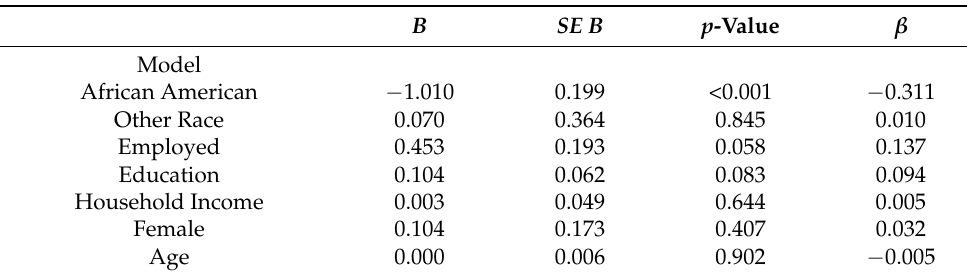
Table 4. Ordinary Least Squares Regression Coefficients to Predict Prevalence of Breastfeeding with Multiple Imputation ( n = 419). B SE B p -Value β Model African American − 1.010 0.199 <0.001 − 0.311 Other Race 0.070 0.364 0.845 0.010 Employed 0.453 0.193 0.058